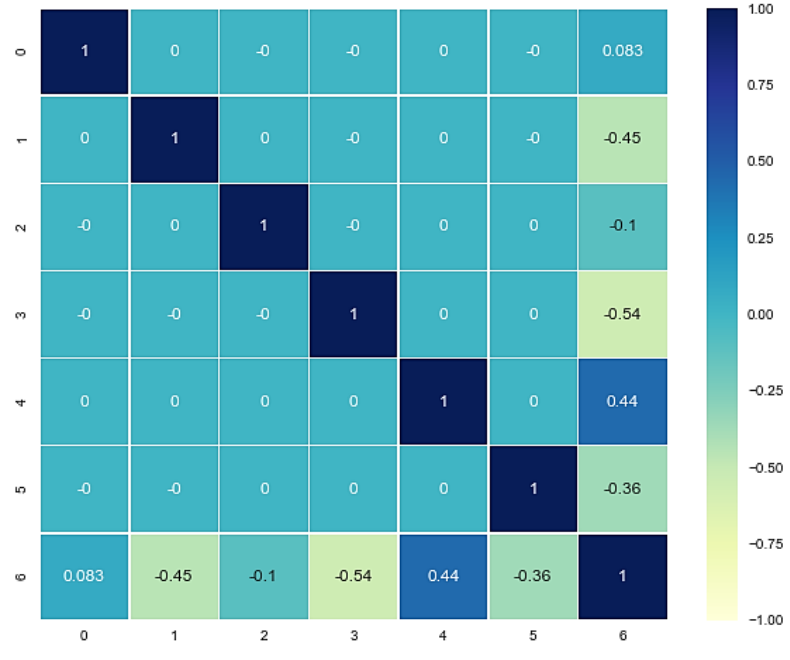
Figure 5. The correlation heatmap between the components and target.